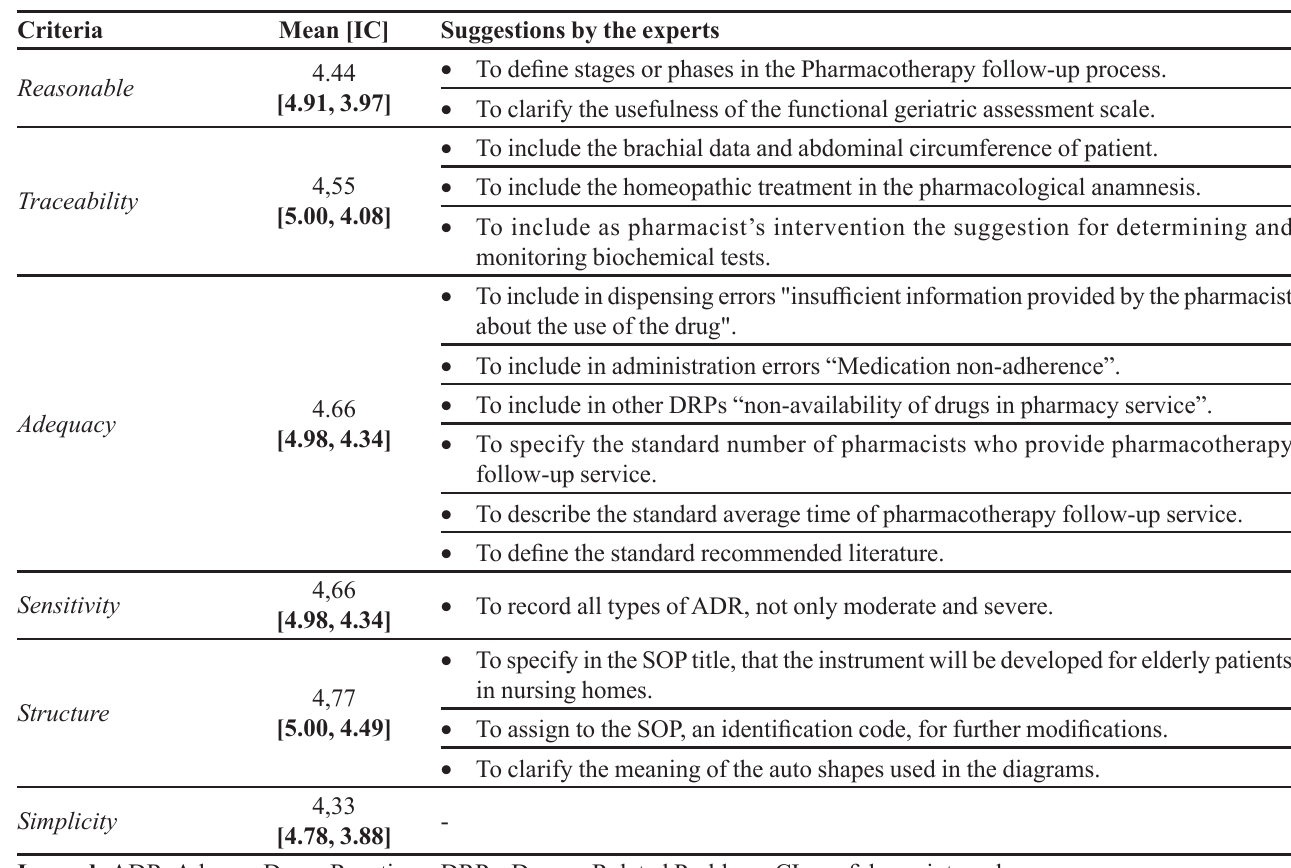
TABLE IV - Assessment results by the expert committee (First Round) Criteria Mean